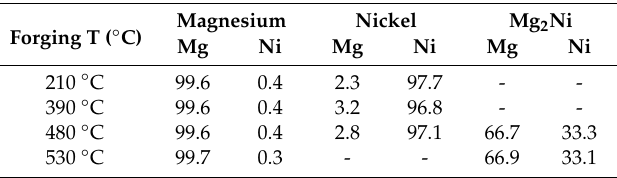
Table 3. Compositions of each phase (EDX analyses,